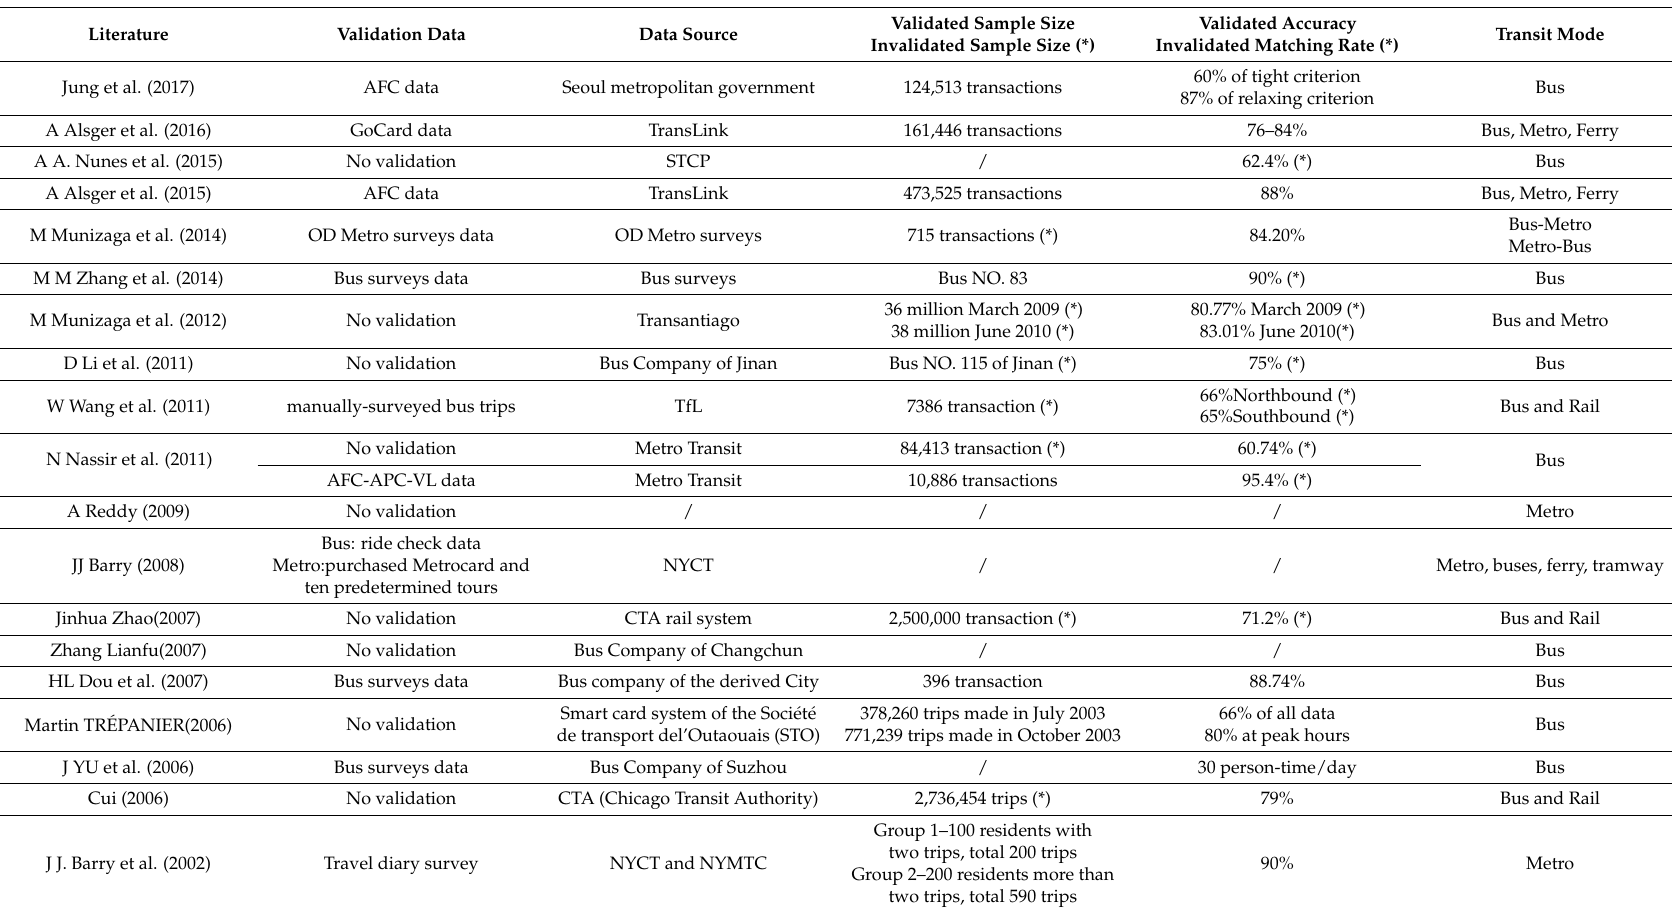
Table 9. Comparison of previous